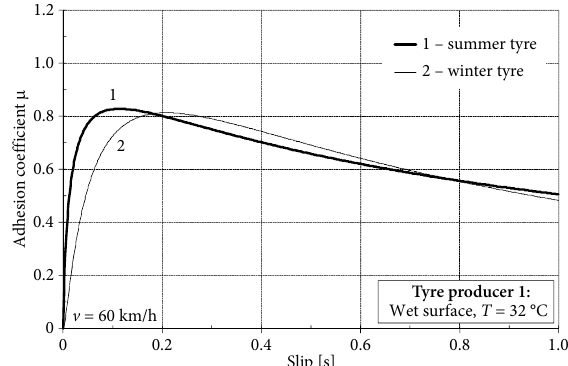
Figure 10. Adhesion characteristics m ( s ) for summer and winter